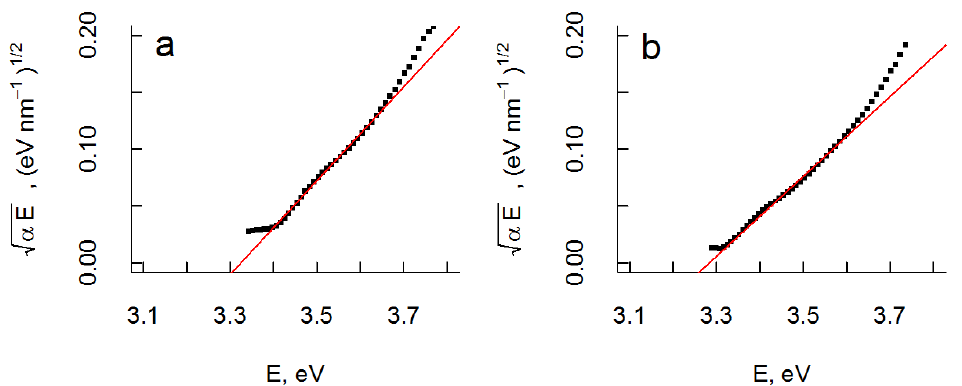
Figure 5. Tauc plots of vs . photon energy, E , and least square linear fit of data for films with ( a ) no orientation and ( b ) preferential <001> orientation. In both cases the optical bandgap was estimated to be 3.3